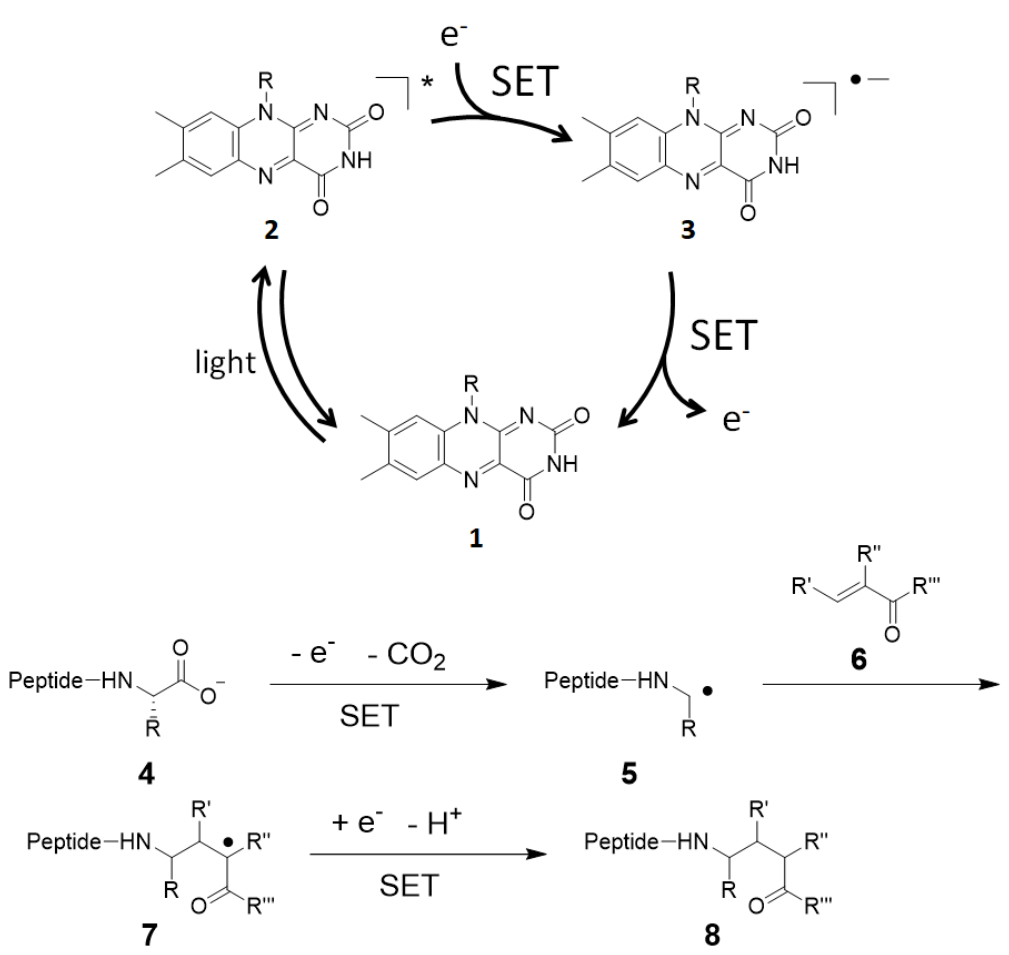
Figure 5. Proposed reaction mechanism for C -terminal labeling with flavin photocatalyst.